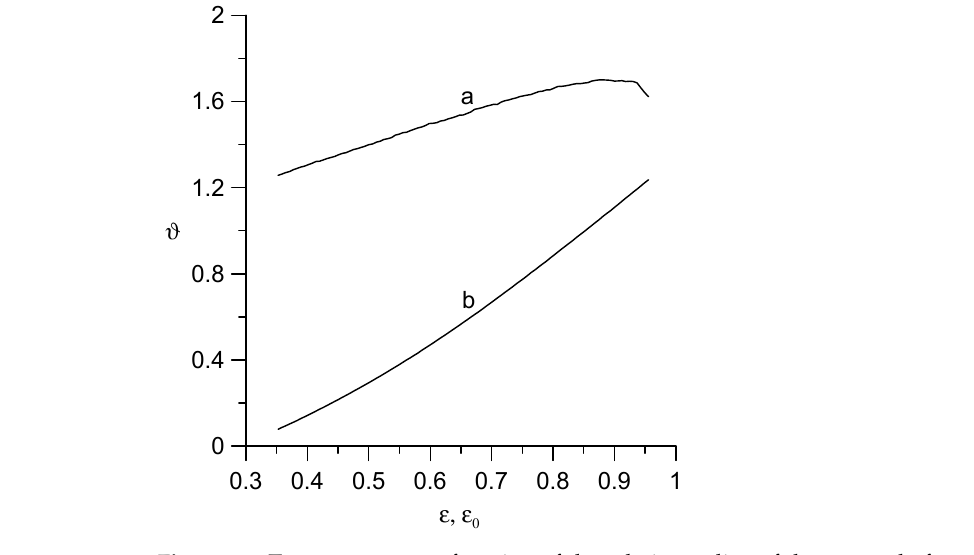
Figure 12. Temperature as a function of the relative radius of the auger shaft ε 0 (a) and the outer radius of the auger ε (b) at the point ξ = 0.8, θ = 0°, ζ = 0.5 for Fo = 0.5, φ 0 = 73.68°, ω = 0.292 Hz, v 0 = 5.89 × 10 − 4 m/s.